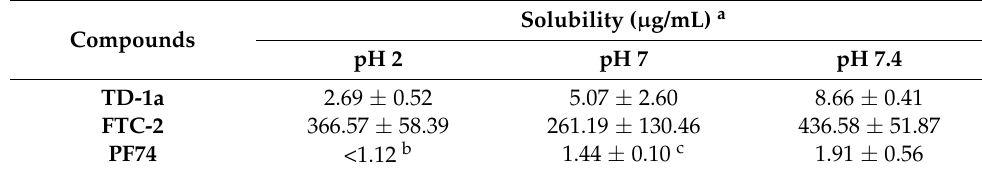
Table 2. Solubility of Representative